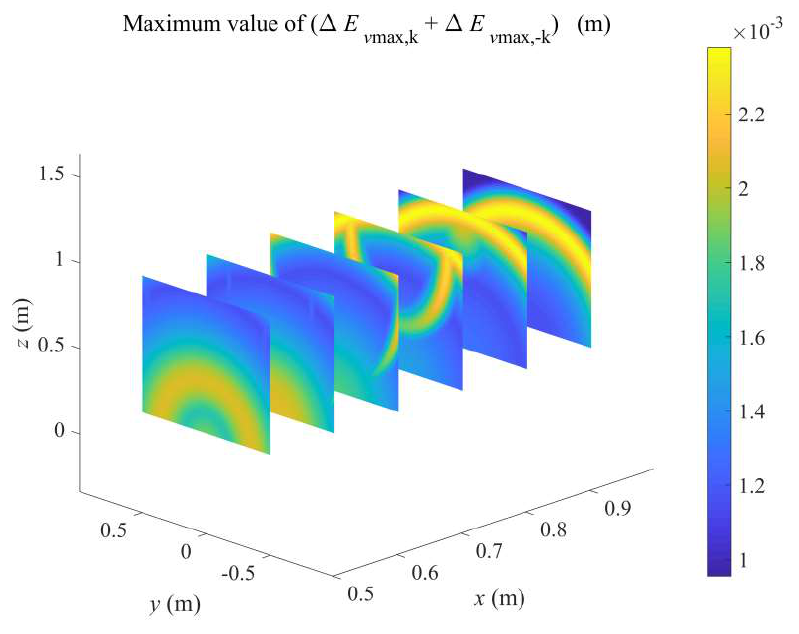
Figure 14. Maximum value of Δ E vmax,k over the operating workspace.